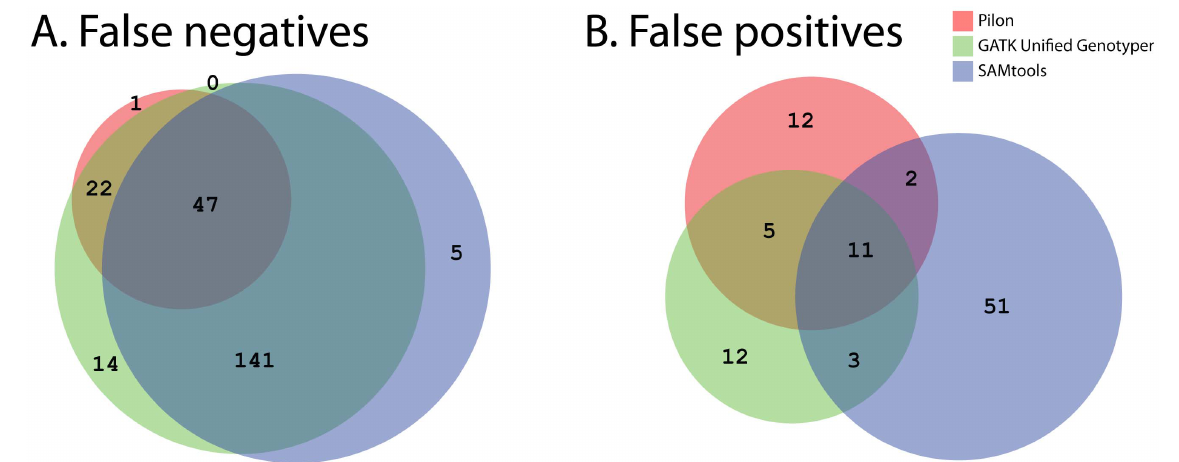
Figure 4. Venn diagram of the overlap in false negative (A) and false positive (B) calls by the three variant detection tools, Pilon, GATK UnifiedGenotyper and SAMtools. False negative calls are the number of unique events from the curation set that was missed by each tool. Overlaps in the Venn diagram show the number of variants that were missed by multiple tools. False positive calls are the number of predictions from M. tuberculosis F11 that were not supported by the curation set. Overlaps indicate predictions that were shared among tools.